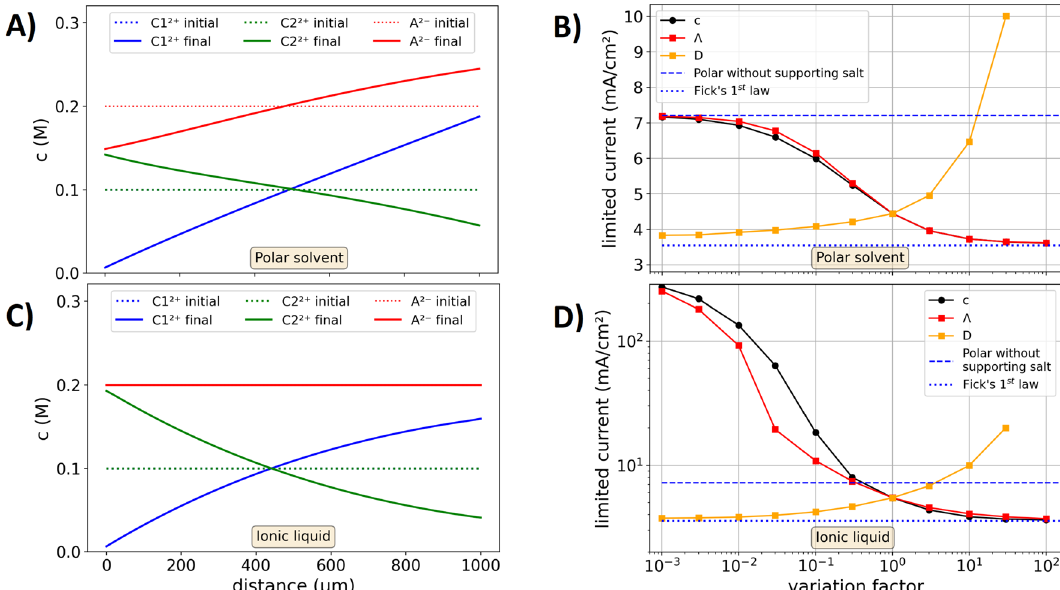
Figure 5. Modeled data to examine the influence of the electrolyte parameters on the limited current for an electrode distance of 0.1cm , an initial concentration of c = 0.1M , a molar conductivity (cid:31) = 100 Scm 2 mol and a diffusion coefficient of D = 10 − 6 cm 2 s − 1 of the supporting salt and the reactive ion pair. ( A ) Concentration gradients obtained for the polar solvent. ( B ) Parameter variation for the polar solvent. The variation factor on the x-axis is multiplied to either the concentration, molar conductivity or diffusion coefficient of the supporting salt. Blue lines: Diffusion-limited current calculated by Fick’s first law and the limited current without addition of supporting salt. ( C,D ) Same as ( A ) and ( B ) but for an ionic liquid, where the ion displacement is confined as described in the text in more